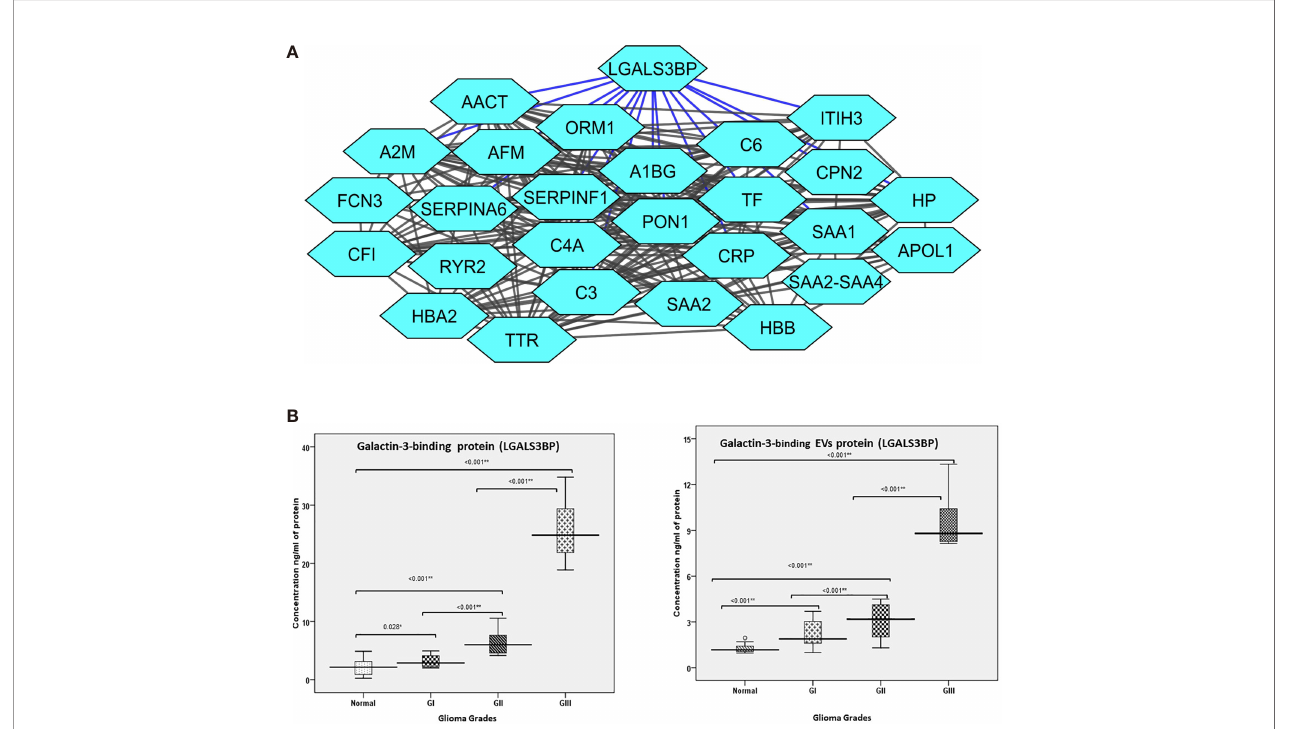
FIGURE 4 | (A) Protein interaction map of galectin-3 binding protein (LGALS3BP) and its interacting proteins and their fold change observed in different grades of glioma. The blue lines represent direct interaction with galectin-3 binding protein. (B) Error bar represents the range between different grades of glioma and normal healthy control of the collected patients in the veri fi cation cohort using ELISA technique. (B) (a) Error bar represents galectin-3 binding protein (LGALS3BP) in plasma. (B) (b) Error bar represents galectin-3 binding protein (LGALS3BP) in extracellular vesicle (EV) protein. * = Signi fi cant and ** = highly signi fi